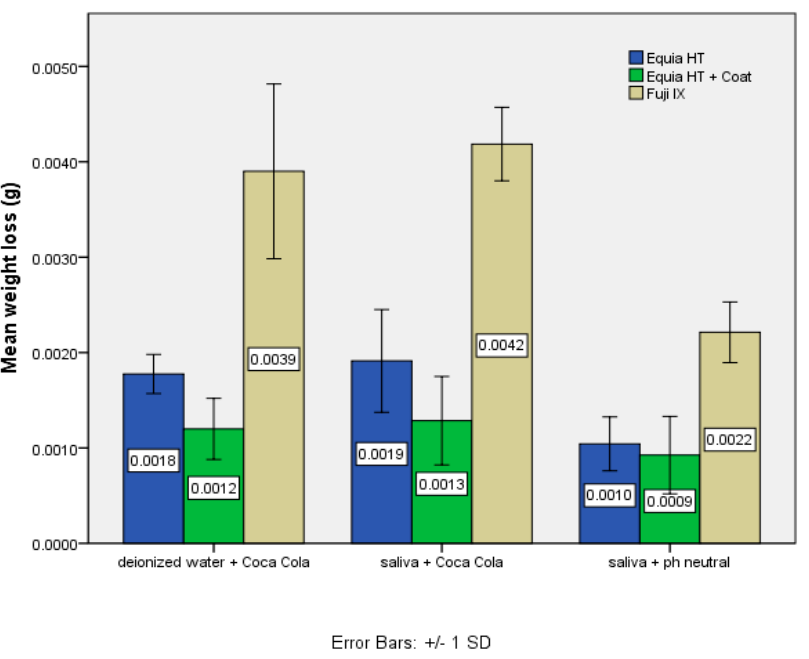
Figure 2. The wear (mean weight loss) of Equia Forte HT Fil with Coat was the lowest, followed by the wear of Equia Forte Fil without Coat. The highest was the wear of Fuji IX GP, considering all storage/acid exposure conditions.